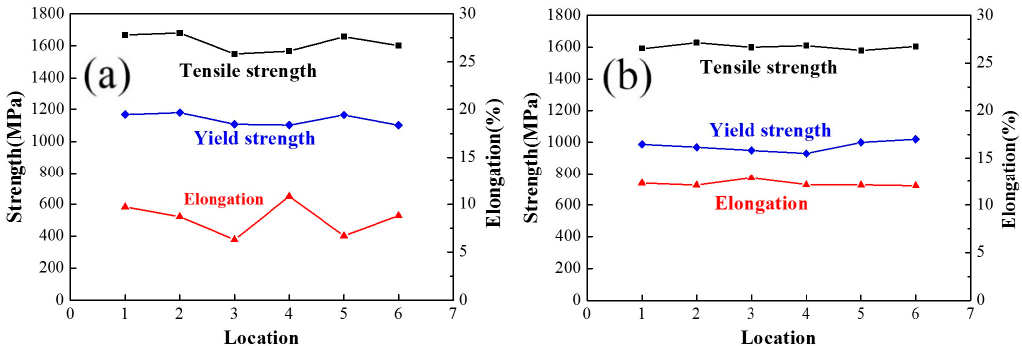
Figure 22. Mechanical properties at six typical locations of the U ‐ shaped parts. ( a ) 22Mn3SiNb, ( b )